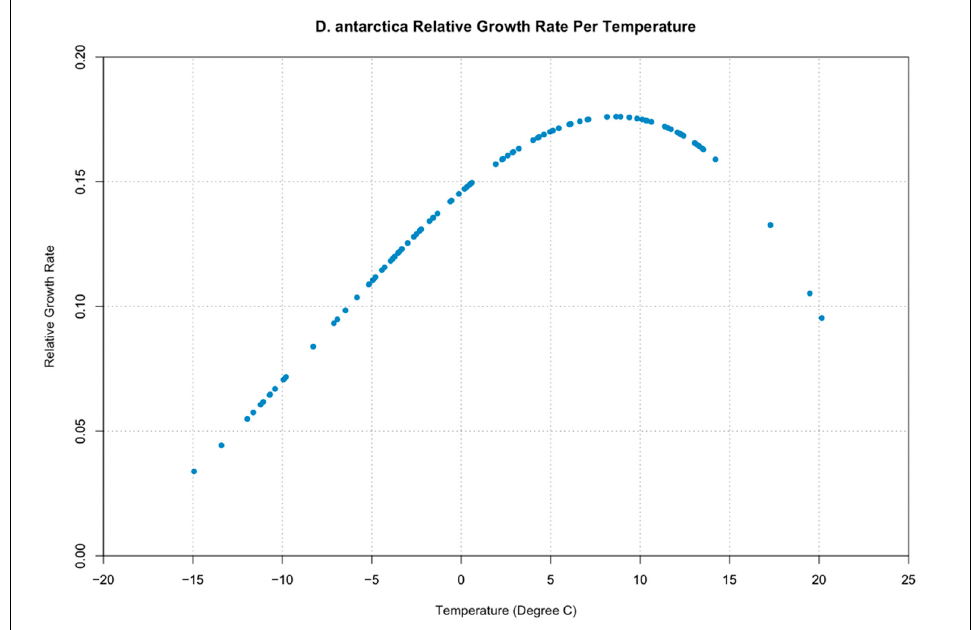
Figure 10. D. antarctica Relative Growth Rate Per Temperature.